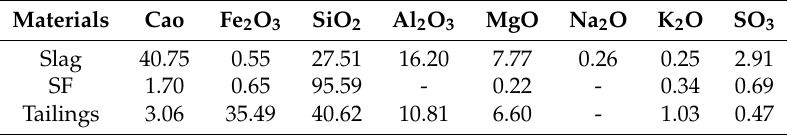
Figure 2. XRD pattern of tailings. Table 1. Chemical composition of raw materials (wt.